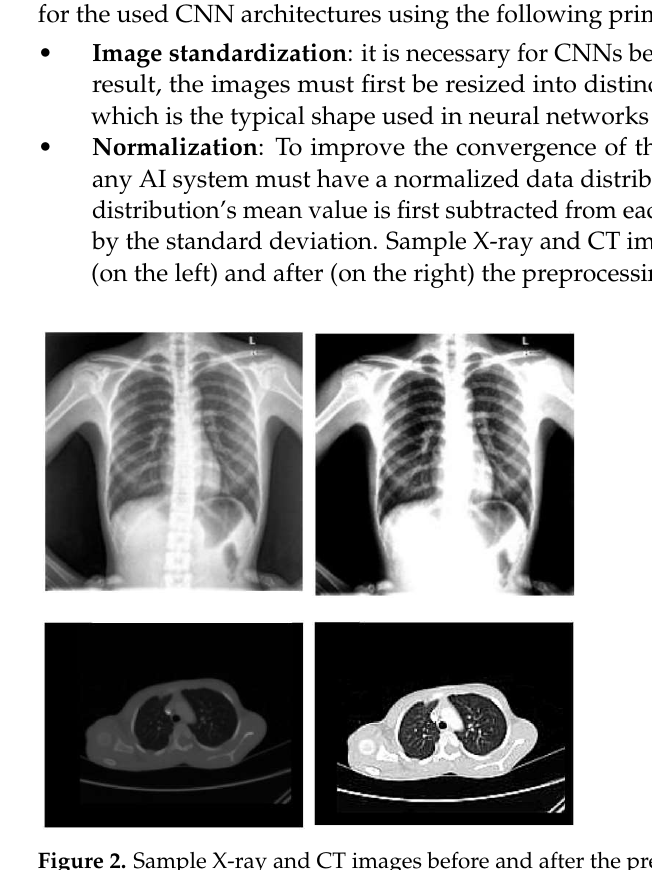
Figure 2. Sample X-ray and CT images before and after the preprocessing